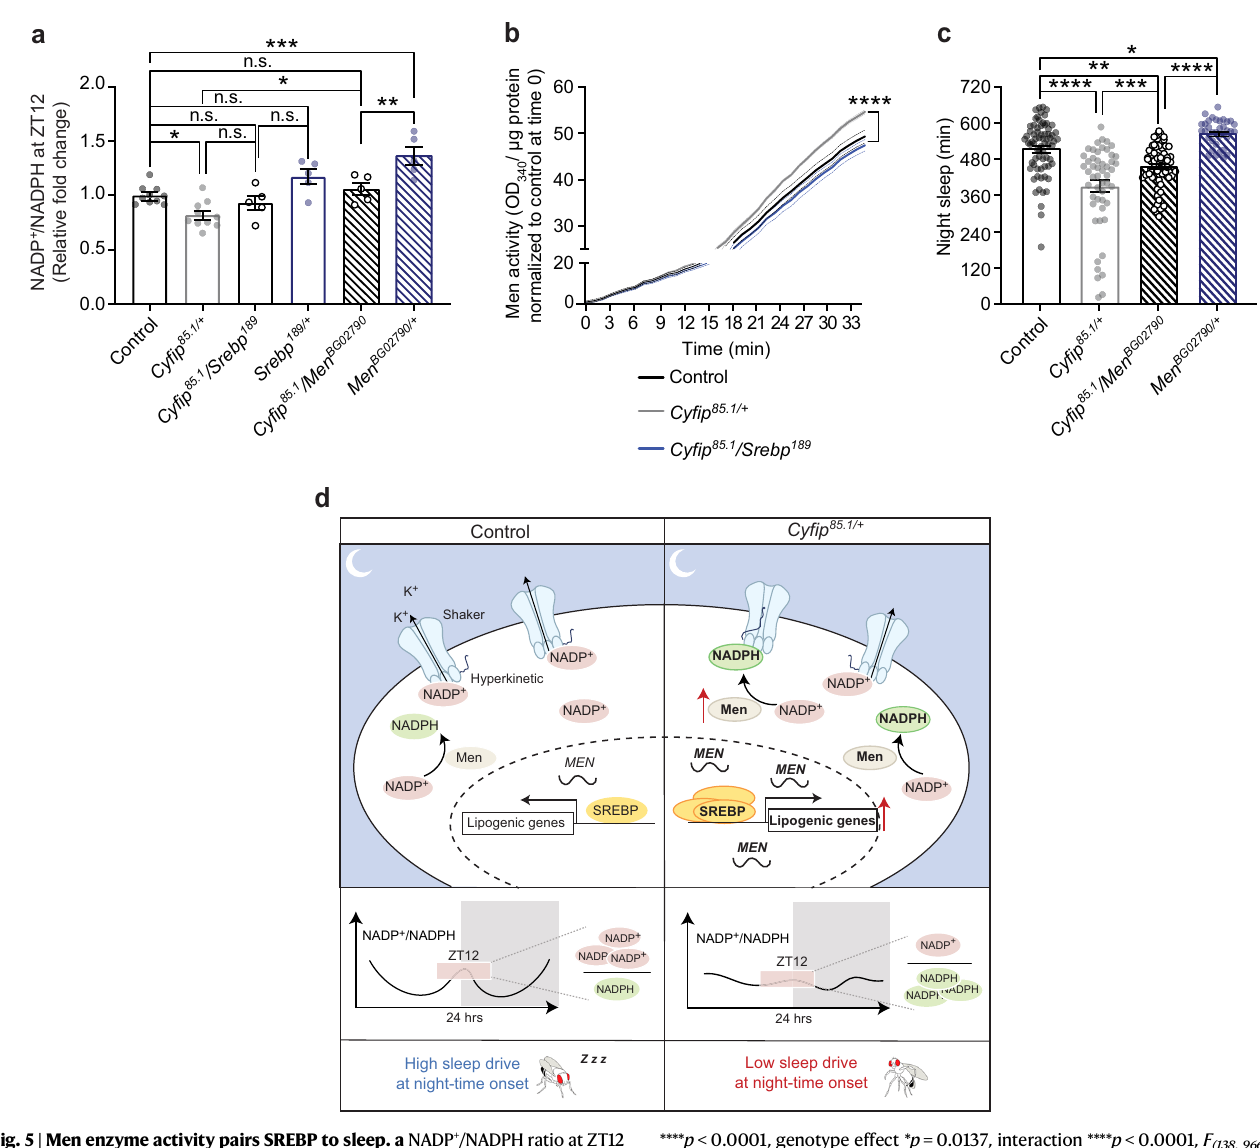
**** p <0.0001, genotype effect *p =0.0137, interaction **** p <0.0001, F (138, 966) = 11.14; control vs. Cy fi p 85.1 /+ * p = 0.0304; Cy fi p 85.1 /+ vs. Cy fi p 85.1 / Srebp 189 ** p = 0.0026; Source Data fi le. d